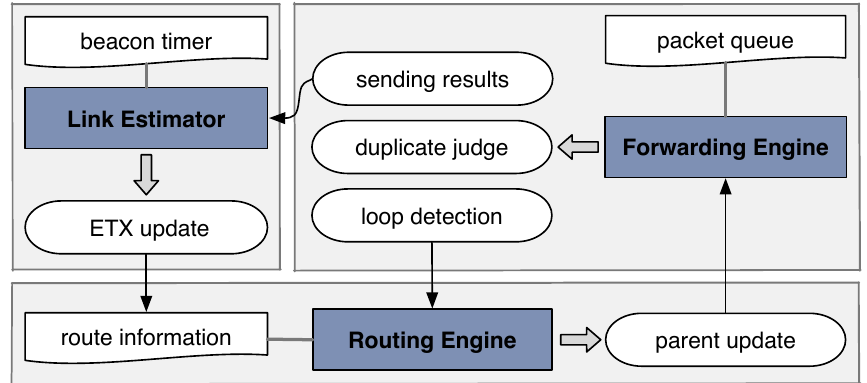
Figure 2. Brief description of the architecture of